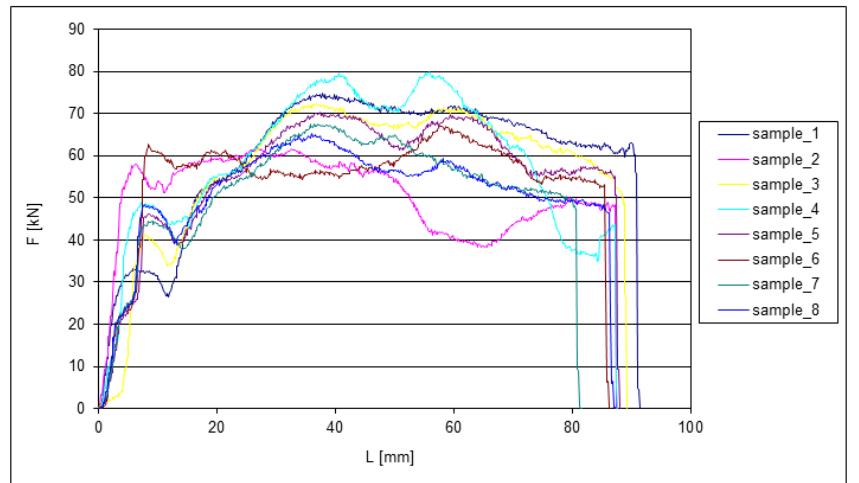
Figure 6. Dependence of the force on the length of the extrusion during the first pass through the ECAP die.